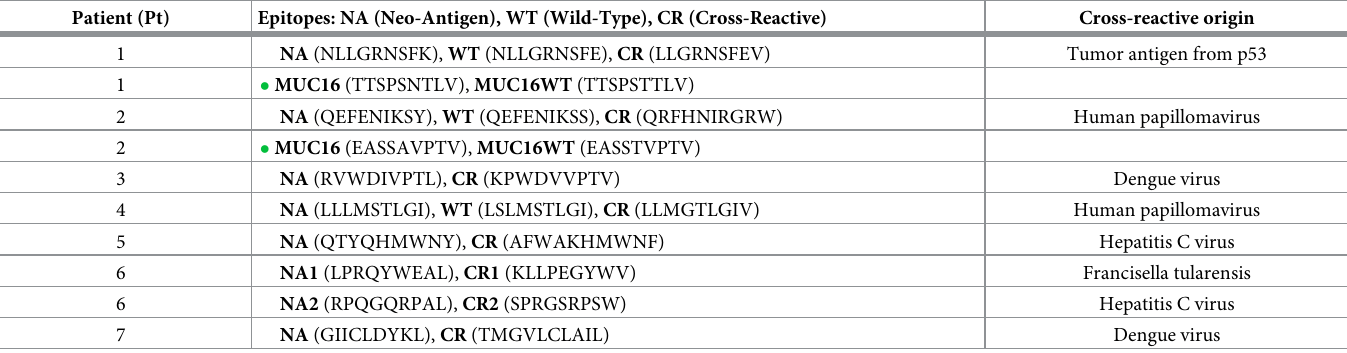
Table 1. List of TRB RepSeq datasets from Ref. [16]. Datasets are organized by patient and by antigens used for the in vitro stimulation of the patient’s PBMC. Neoanti- gens tested were chosen based on a measure of neoantigen “fitness” that accounts for: the neoantigen binding affinity to the patient’s MHC; its potential for being recog- nized by T cells, quantified by sequence similarity to infectious disease-related epitopes (“cross-reactive”), see [9, 16]. The neoantigens are generated by cancer-specific point mutations in antigens natural to the organism (“wild-type”). The green circle indicates neoantigens from the genetic locus MUC16, which were not selected based on neoantigen